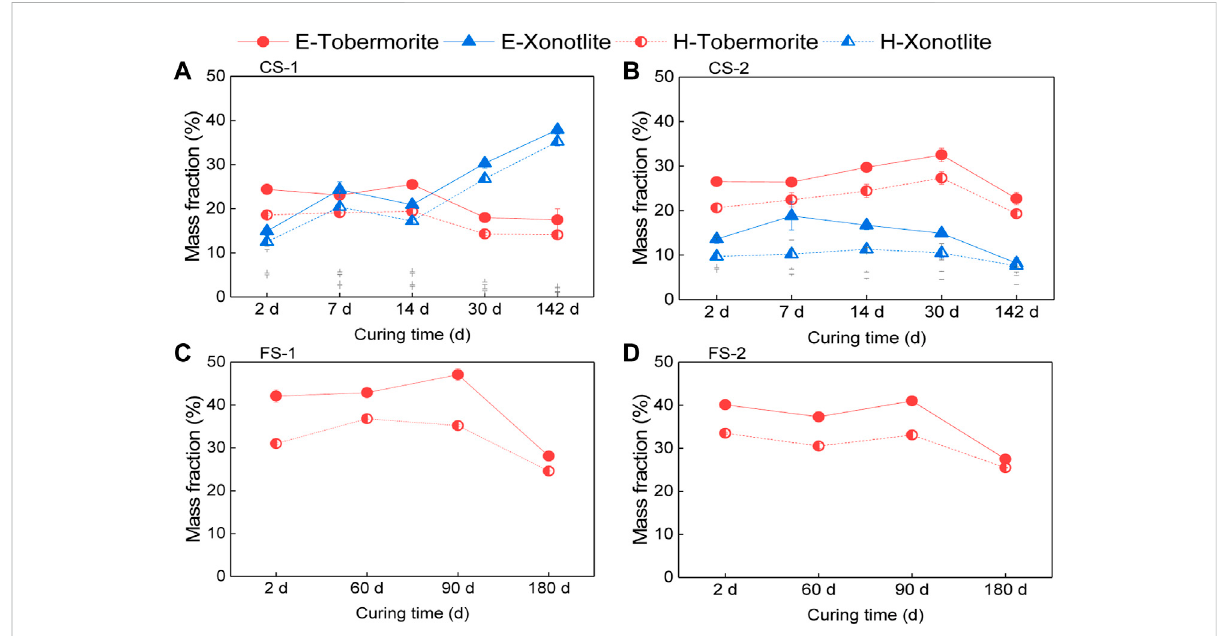
FIGURE 11 Comparisonofthecrystallinephasecontentsobtainedbydifferentmethods.(E:theexternalstandardmethod;P:thePONKCSmethods;H:the hybrid method). (A) slurry CS-1 (B) slurry CS-2 (C) slurry FS-1 (D) slurry